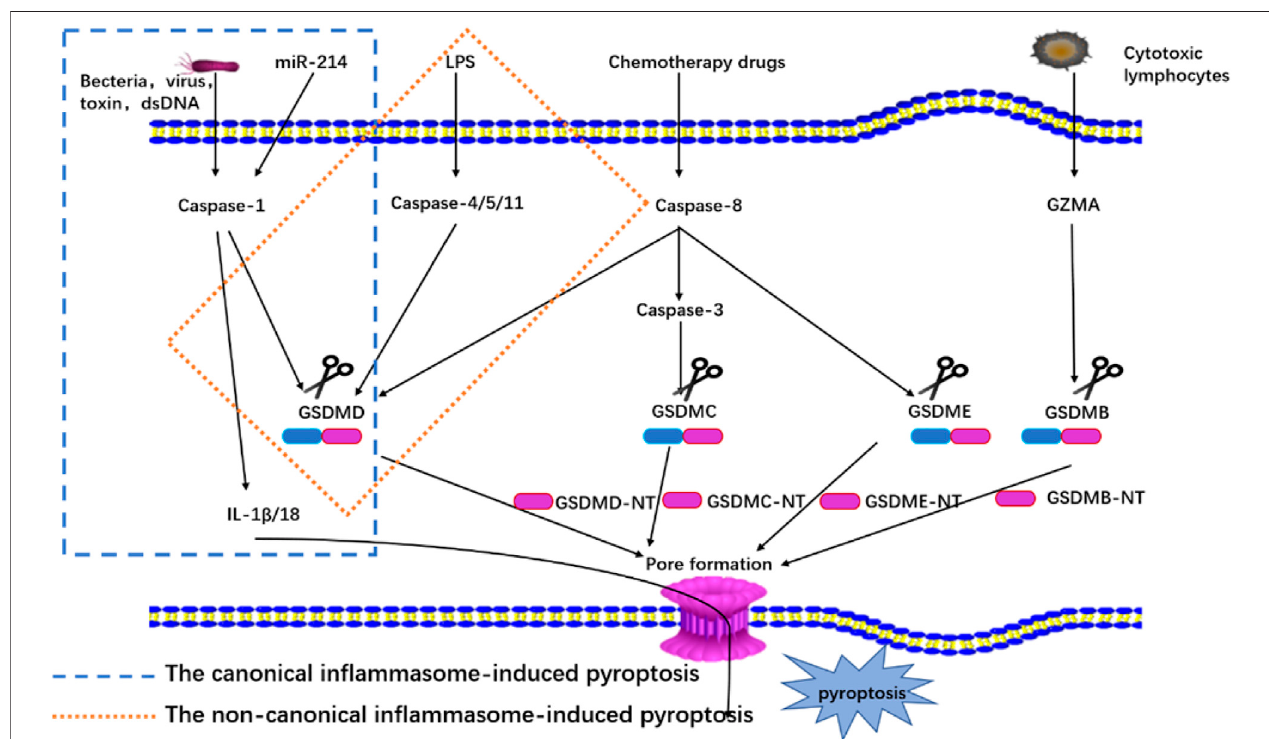
FIGURE 1 | Mechanisms of